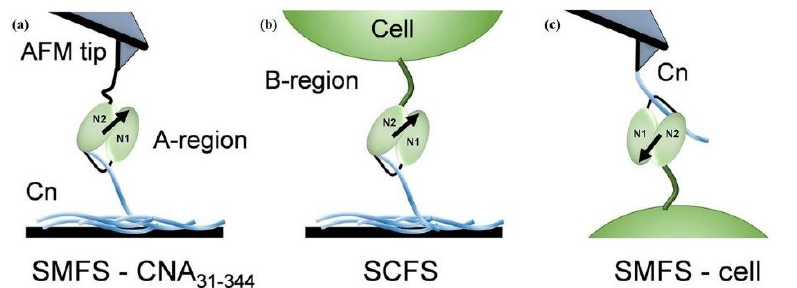
Figure 12. Atomic force microscopy analysis of the Cna-Cn interaction in vitro and in vivo. ( a ) Single-molecule force spectroscopy (SMFS) of recombinant CNA 31–344 , i.e., a portion of the A region that contains the ligand-binding domains. Single-cell force spectroscopy (SCFS; b ) and SMFS ( c ) of full-length Cna expressed in S. aureus Phillips bacteria (for the sake of clarity, the N3 domain is not shown in the middle and right cartoons). As illustrated, Cna binds to Cn via the collagen hug mechanism, where the N1N2 subdomains cooperate to wrap around the rope-like structure of collagen. (Reproduced with permission from [137] under Creative Commons Attribution 4.0 International License).